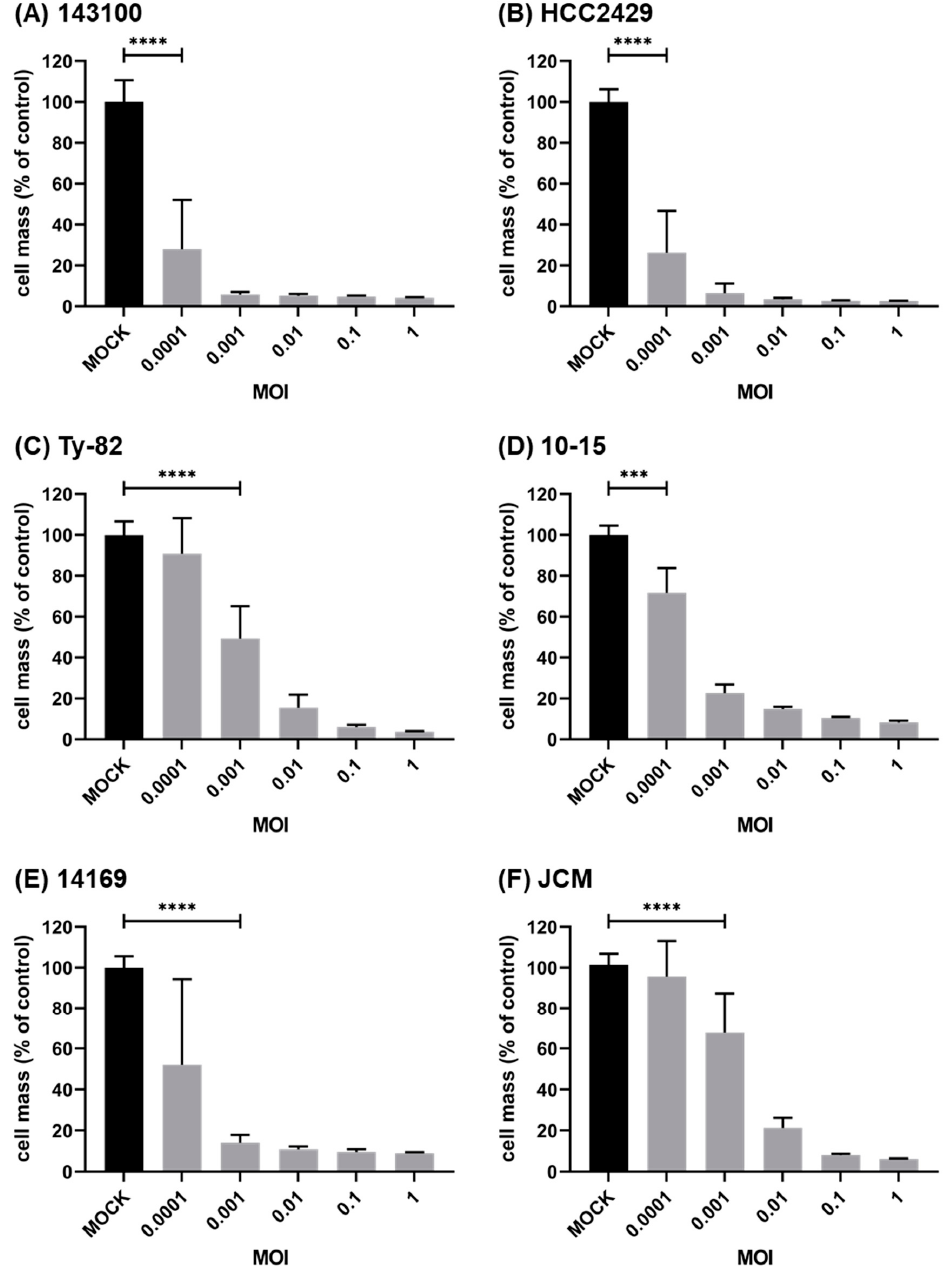
Figure 2. Viability of human NC cell lines after monotherapeutic treatment with T-VEC: 143100 ( A ), HCC2429 ( B ), Ty-82 ( C ), 10-15 ( D ), 14169 ( E ), and JCM ( F ) NC tumor cells were infected with T-VEC at different multiplicities of infection (MOIs) ranging from 0.0001 to 1 or remained uninfected (MOCK). At 96 h post infection (hpi), the remaining NC tumor cells were determined by SRB viability assay. T-VEC-mediated oncolysis was calculated relative to MOCK control. The mean ± SD of at least two independent experiments performed in quadruplicates is shown. *** p < 0.001, **** p <